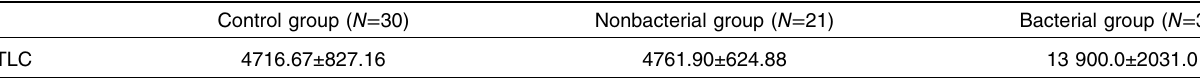
Table 8 Comparison between mean values of TLC in the studied groups